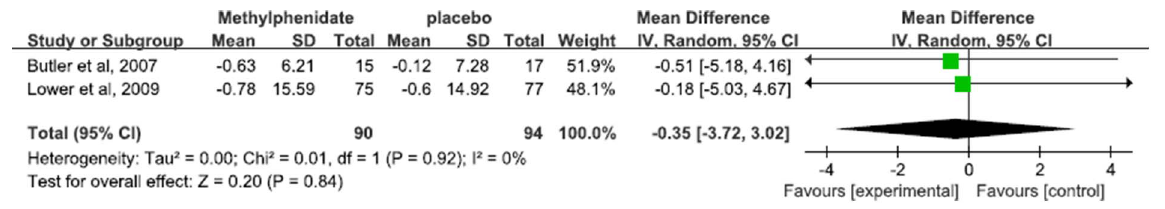
Figure 5. Effect of Methylphenidate on cognition associated with CRF.